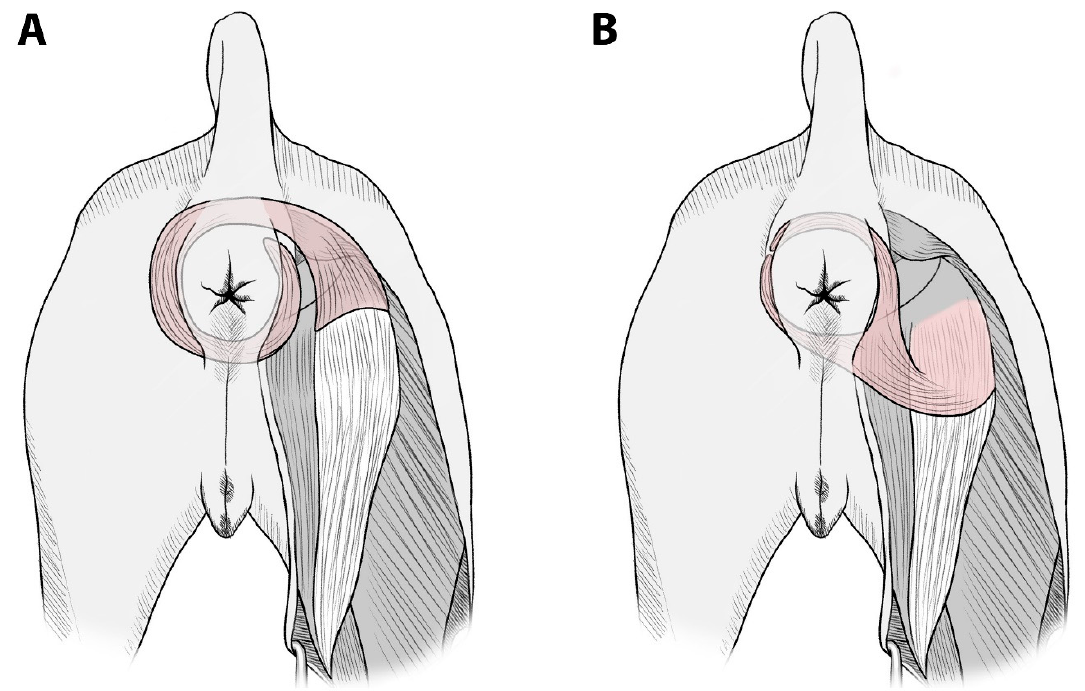
Figure 5. Illustration of the two possible options of semitendinosus muscle transposition for total replacement of the external anal sphincter in a dog. ( A ) To completely encircle the anus, a long semitendinosus muscle is needed. ( B ) By bifurcating the distal end of the semitendinosus muscle, the required flap length can be substantially reduced, leading to less impairment of the integrity of the vasculature and nerve supply to the proximal part of the semitendinosus muscle.